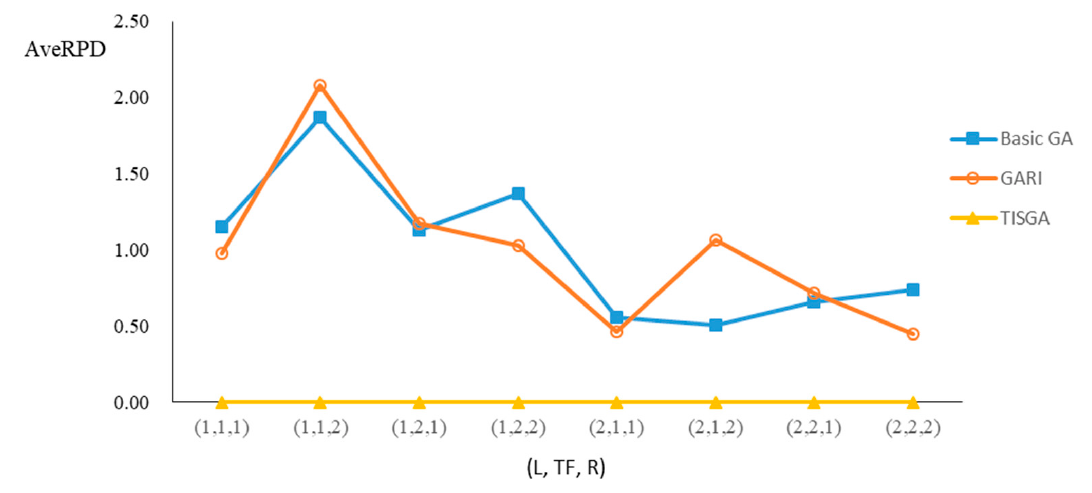
Figure 13. Comparison results for n = 45 with eight combinations of (L, TF, R).